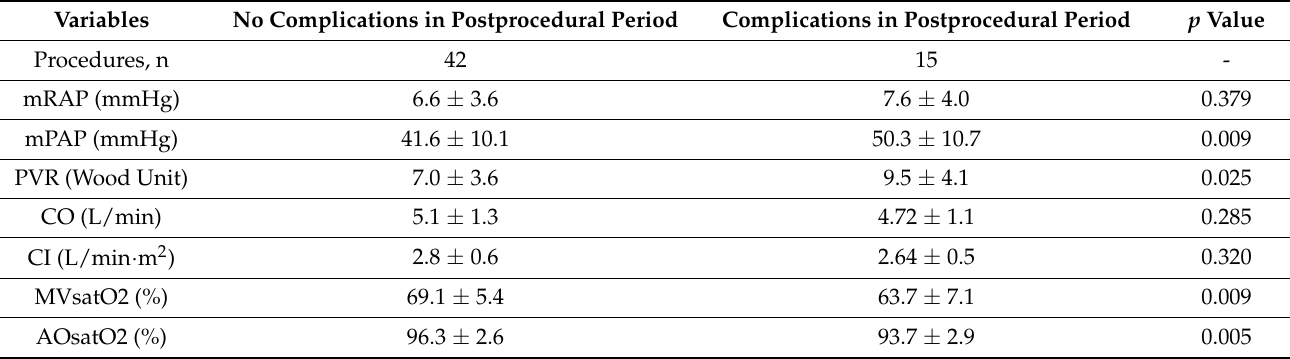
Table 3. Hemodynamic parameters in the groups with and without complications in the postprocedural period.